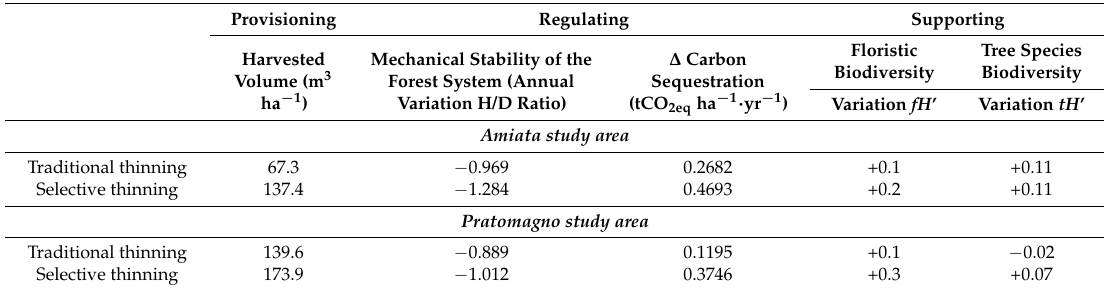
Table 6. Comparison among ecosystem services in the two study